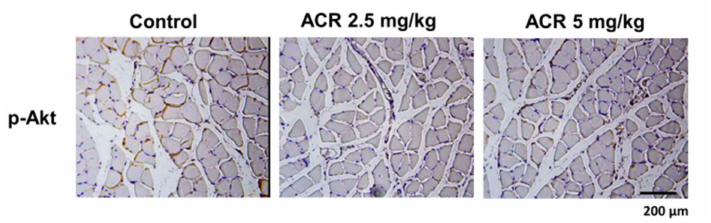
Figure 7. Effects of acrolein on the expression of phosphorylated Akt in the soleus muscles of mice. Mice were treated with acrolein (2.5 or 5 mg/kg) by oral gavage daily for 4 weeks. The representative immunohistochemical images for phosphorylated Akt expression in the soleus muscles isolated from each group are